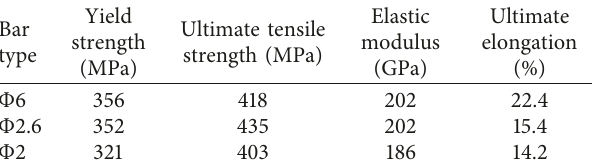
Table 2: Mechanical properties of reinforcing